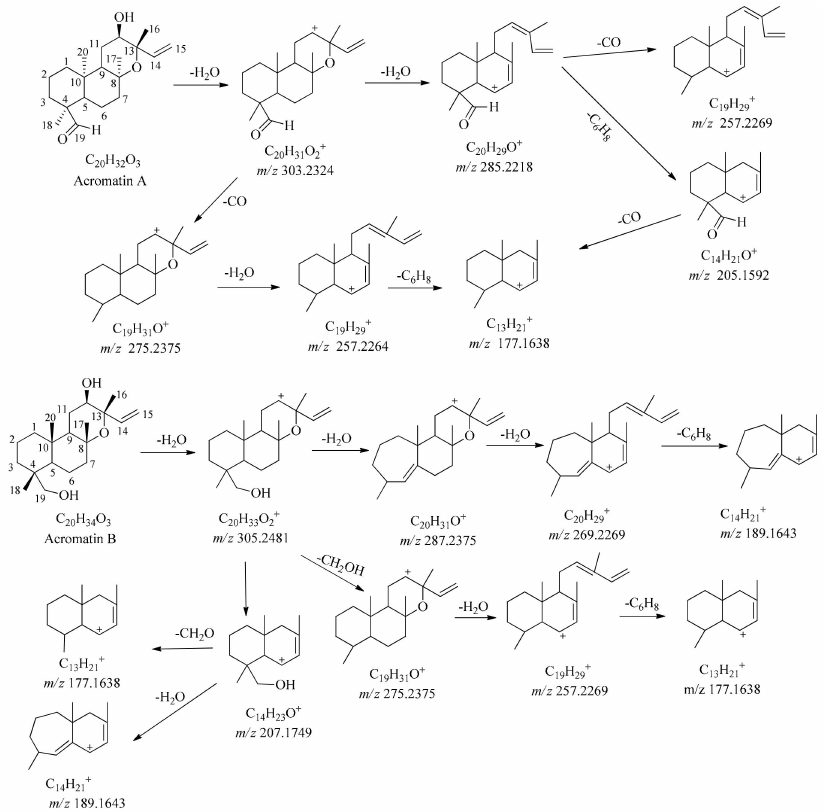
Figure 6. Proposed cleavage pathway and the MS / MS spectra of acromatin A and acromatin